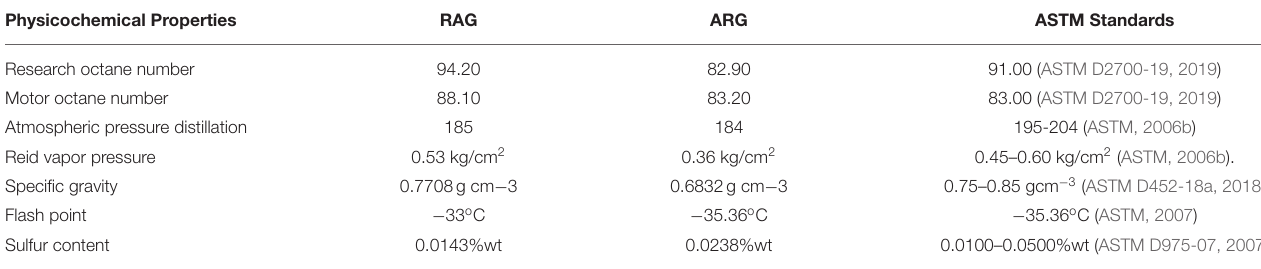
TABLE 8 | Summary of comparative physicochemical properties of RAG and ARG. Physicochemical